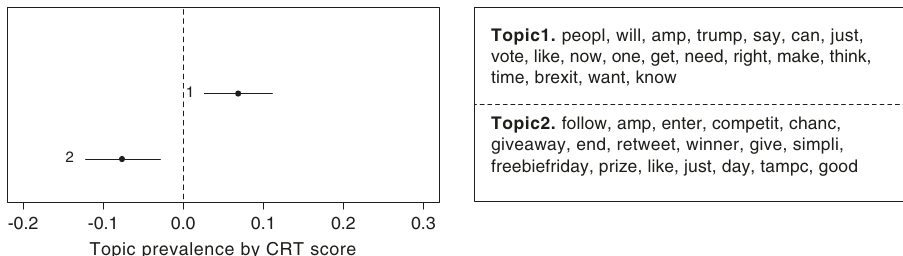
Fig. 3 Difference in topic proportion against CRT score of users. Topic 1 related to political engagement is positively correlated with CRT score and Topic 2 involving “ get rich quick ” schemes is negatively correlated with CRT score.